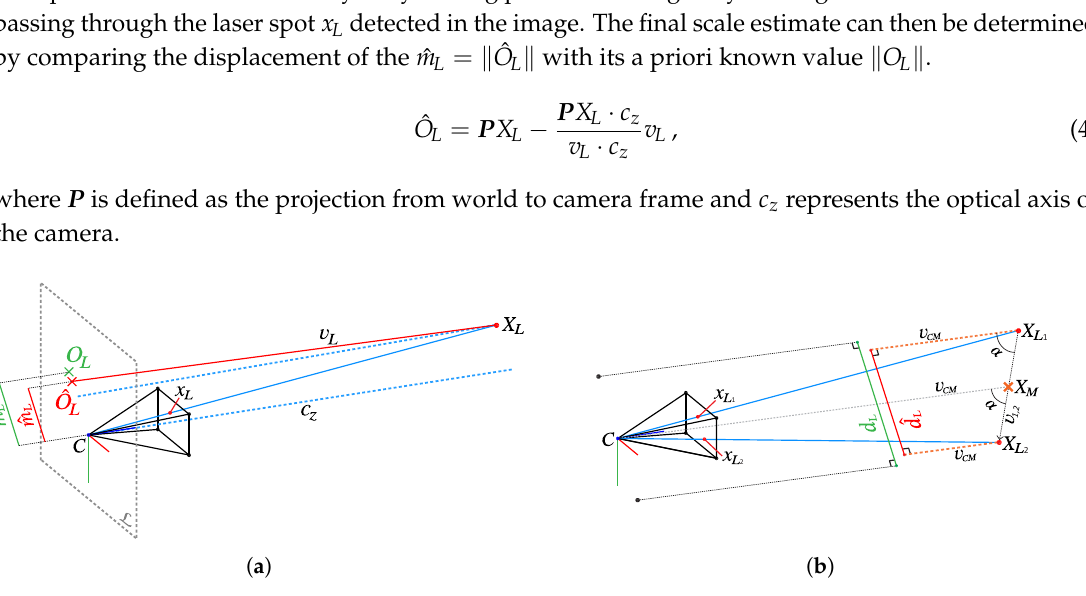
Figure 5. Scale estimation using ( a ) fully-unconstrained and ( b ) partially-constrained approach, based on the 3D model and optical image depicting the laser beam projection on the scene intersection with the